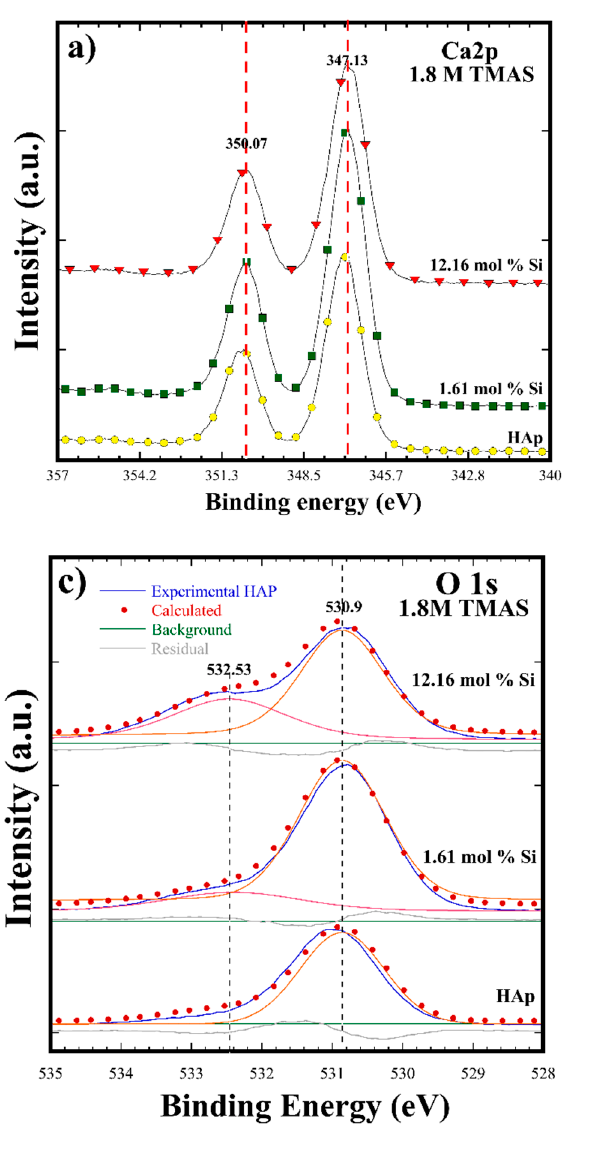
Figure 6. The XPS analysis for HAp and Si-HAp powders obtained by microwave assisted hydrothermal process at 150 °C for 1 h using 1.8 M of the TMAS solutions with different mol% Si: ( a ) Ca 2p; ( b ) P 2p; ( c ) O 1s; ( d ) Si 2p .